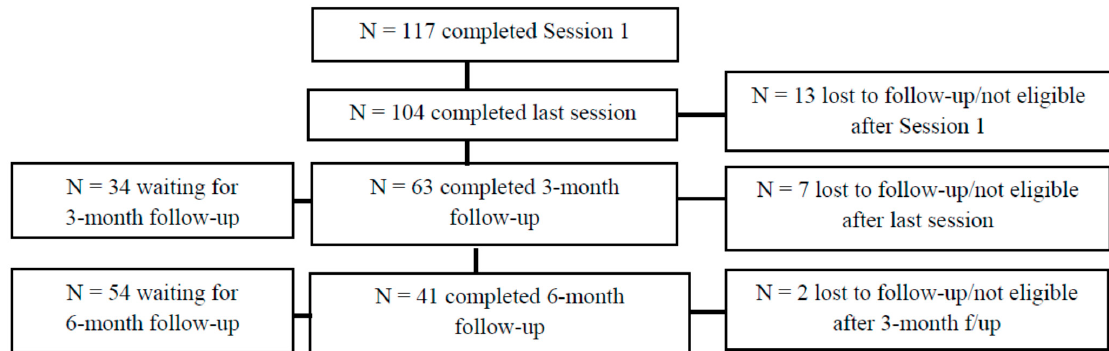
Figure 1. OST CHOICES program: individual session data.